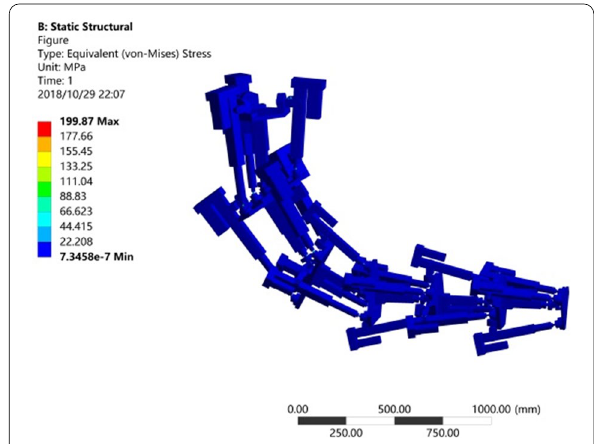
Figure 14 Static stiffness analysis of HRETR